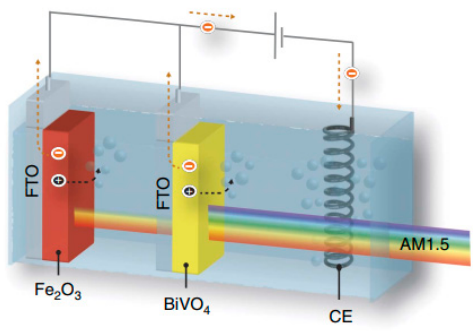
Figure 8. Wavelength-selective solar light absorption by hetero-type dual photoanode. Reprinted with permission from ref. [23]. Copyright 2018. Nature.